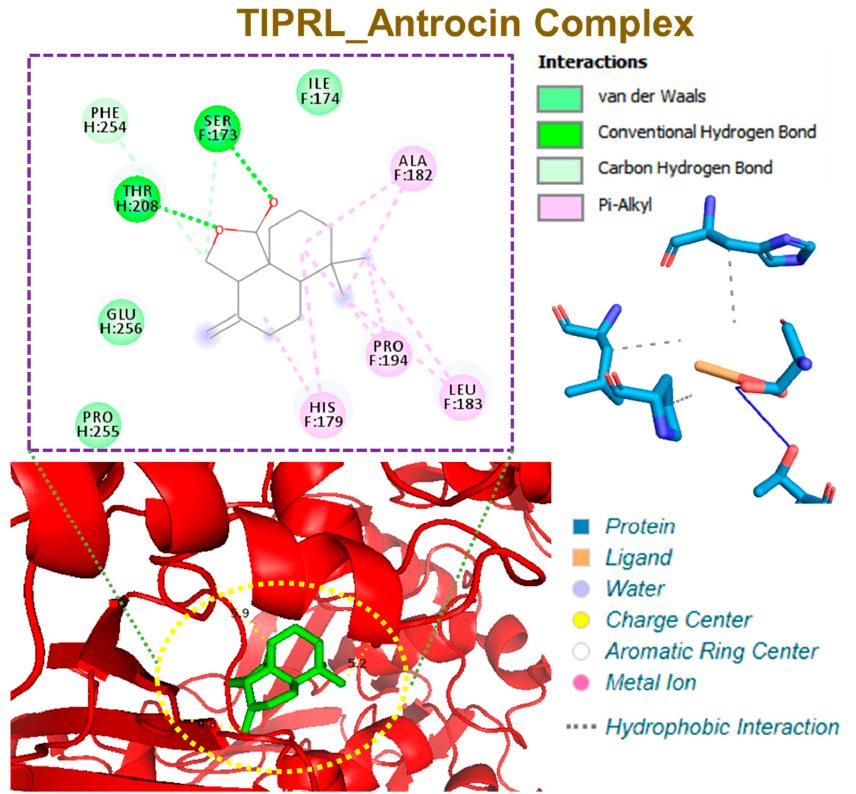
Figure 9. Molecular docking profile of TIPRL with antrocin.